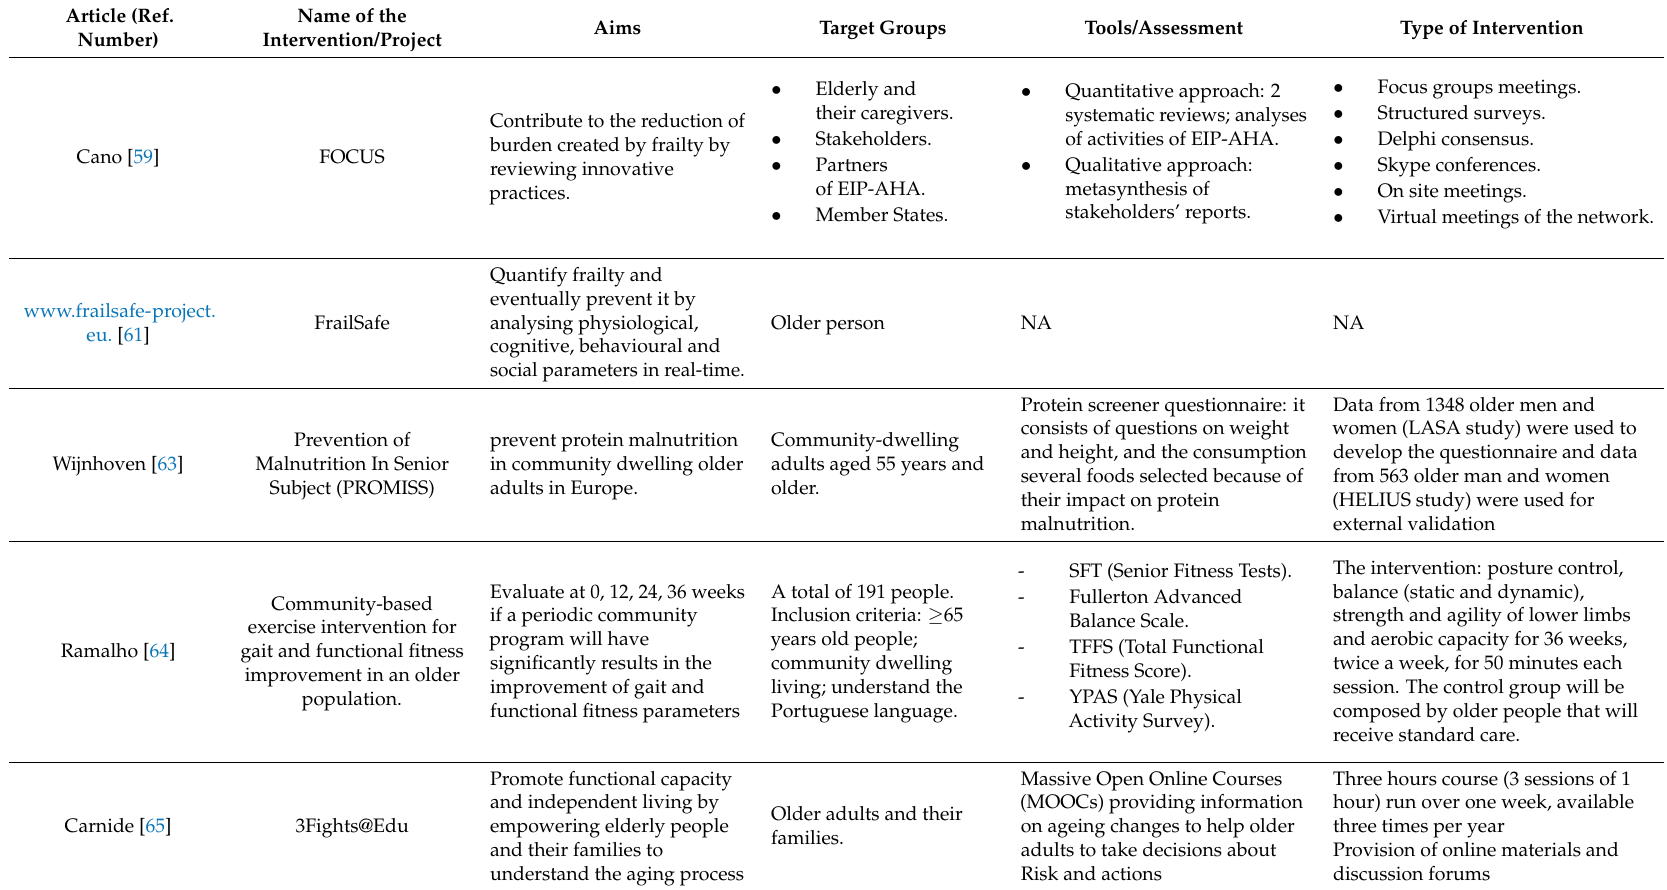
Table 3. Interventions to mitigate frailty and its